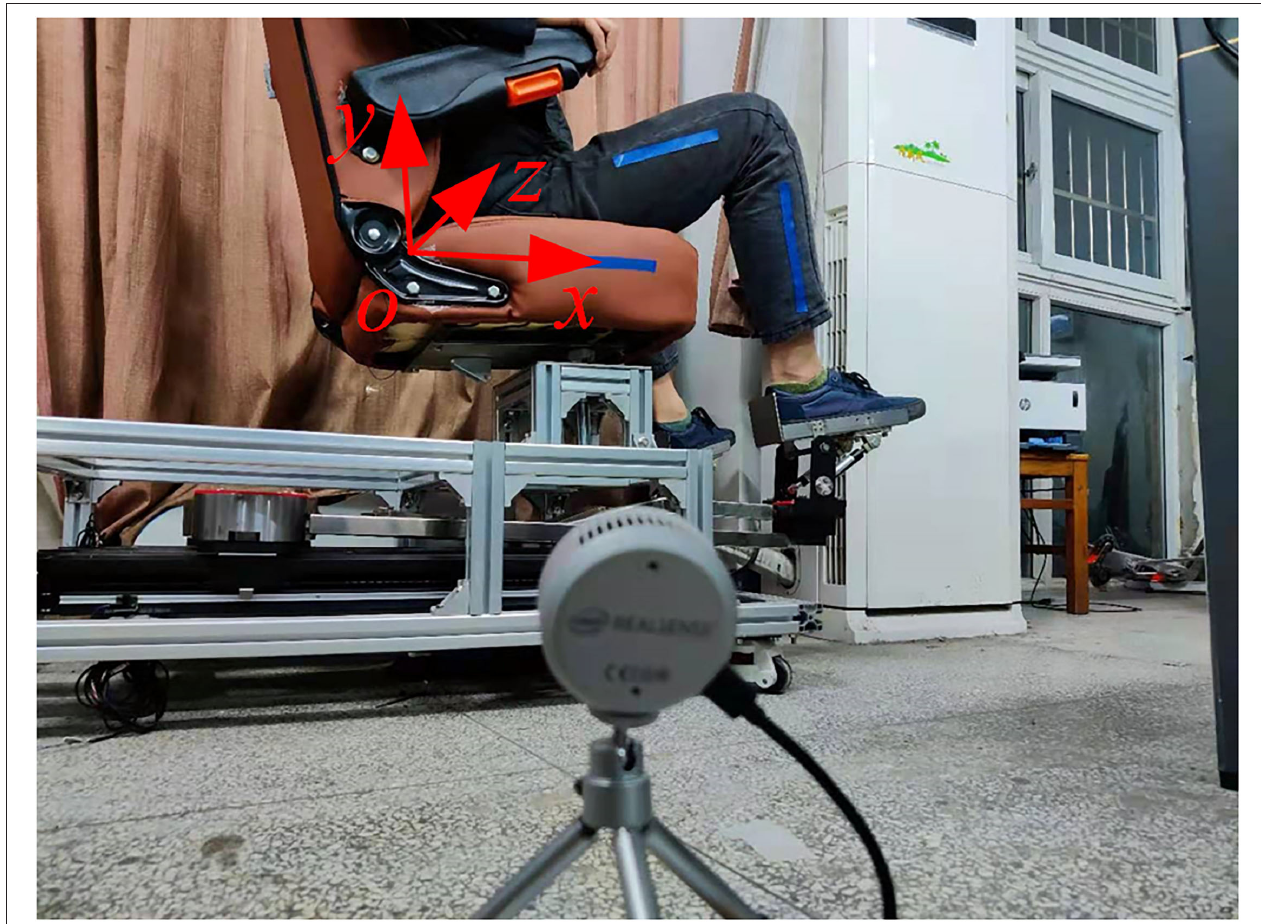
FIGURE 4 | Position arrangement of the camera and